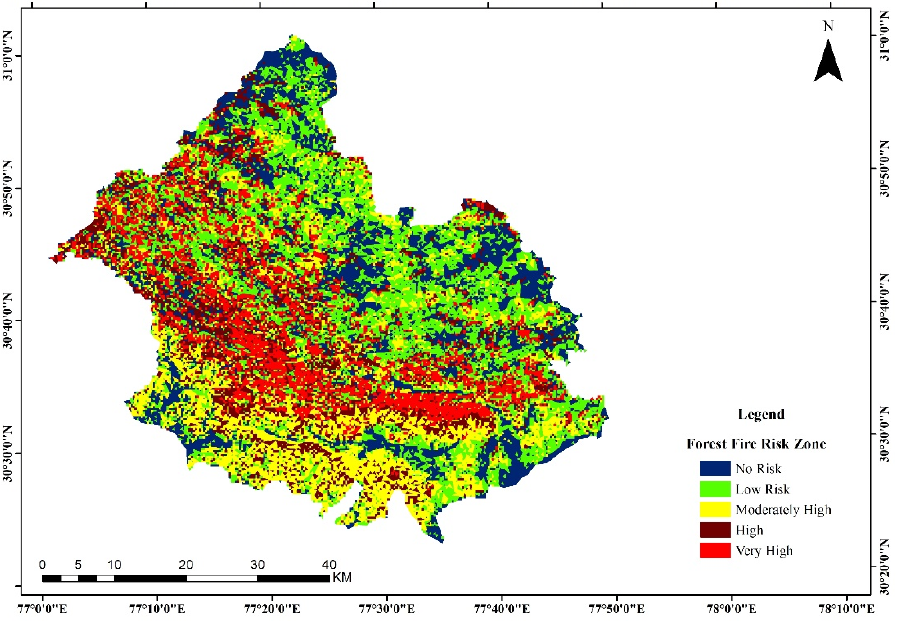
Figure 14. Forest fire risk map.